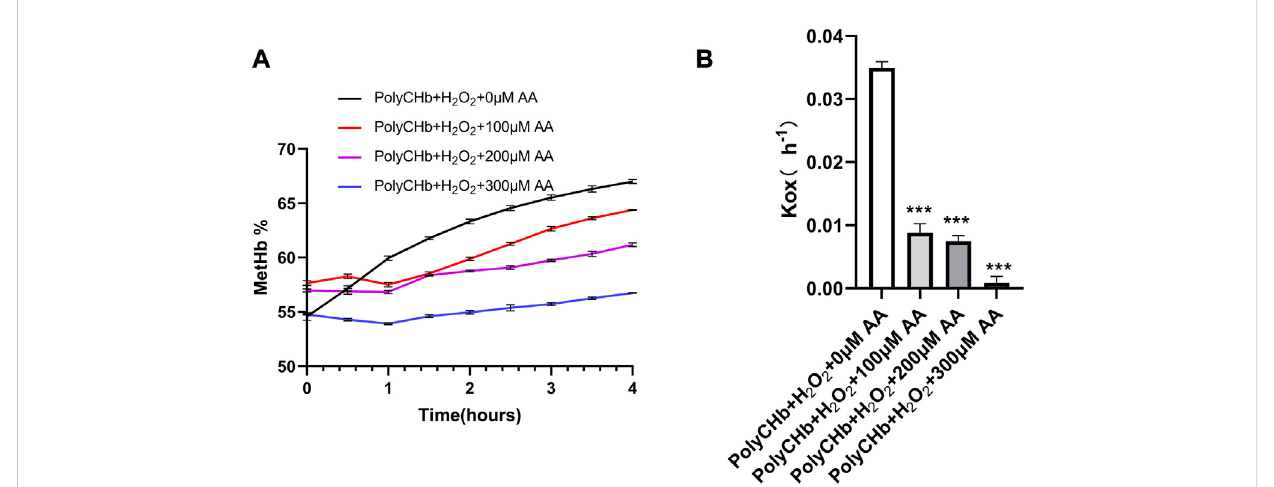
FIGURE 3 Intervention of AA on PolyCHbFe 2+ oxidation under H 2 O 2 at 37 ° C, (A) , the content of MetHb before and after AA addition, (B) , the Kox before and after AA addition, Values are expressed as mean ± SEM, n = 3.